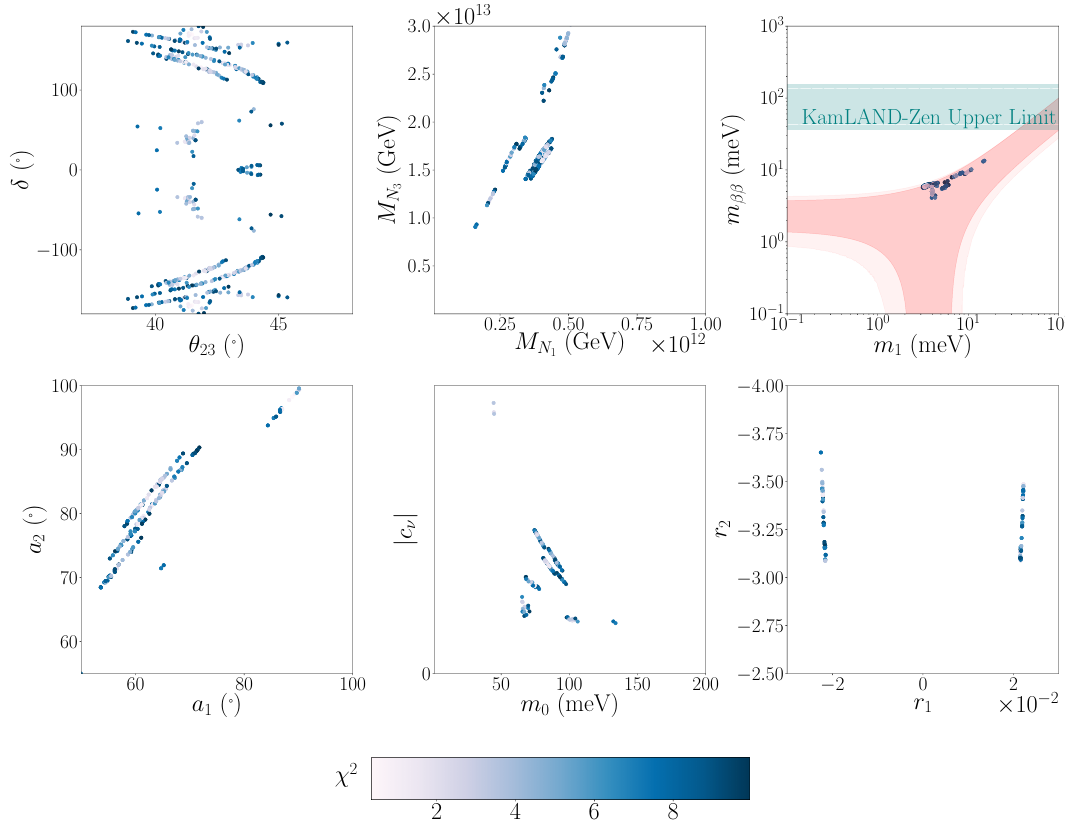
Figure 4 . The predicted observables (top left two panels), the effective neutrino mass prediction (top right panel) and two-dimensional correlations between theory inputs (bottom panels) for χ 2 < 10 and θ 45 ◦ . Consistency with gauge unification is 23 ≤